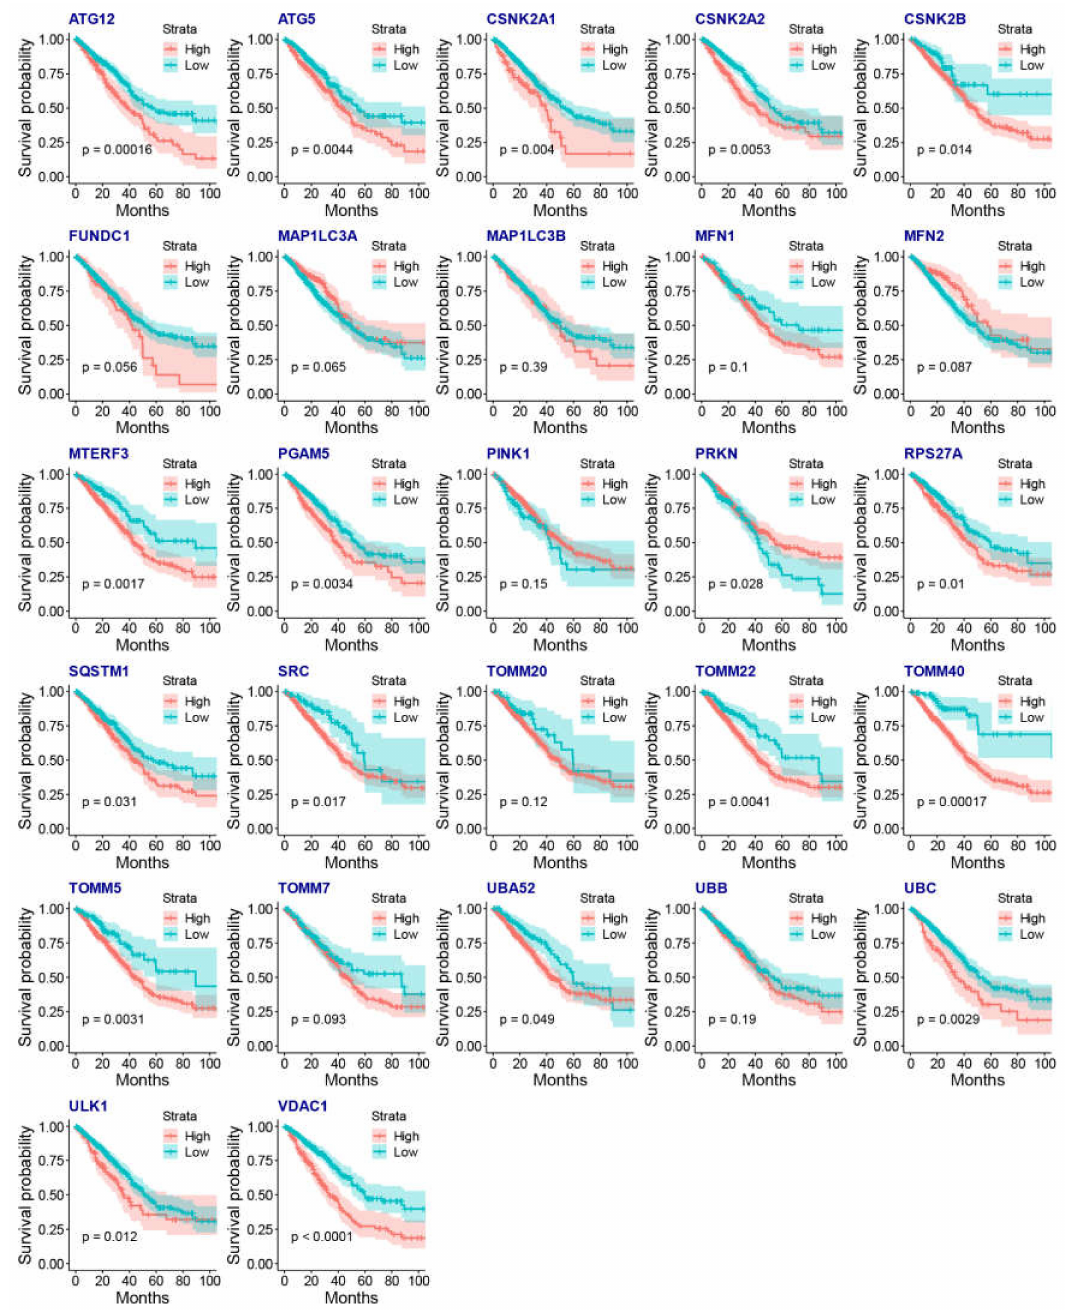
Figure 4. The association between the gene expression of mitophagy genes and the OS of LUAD by KM